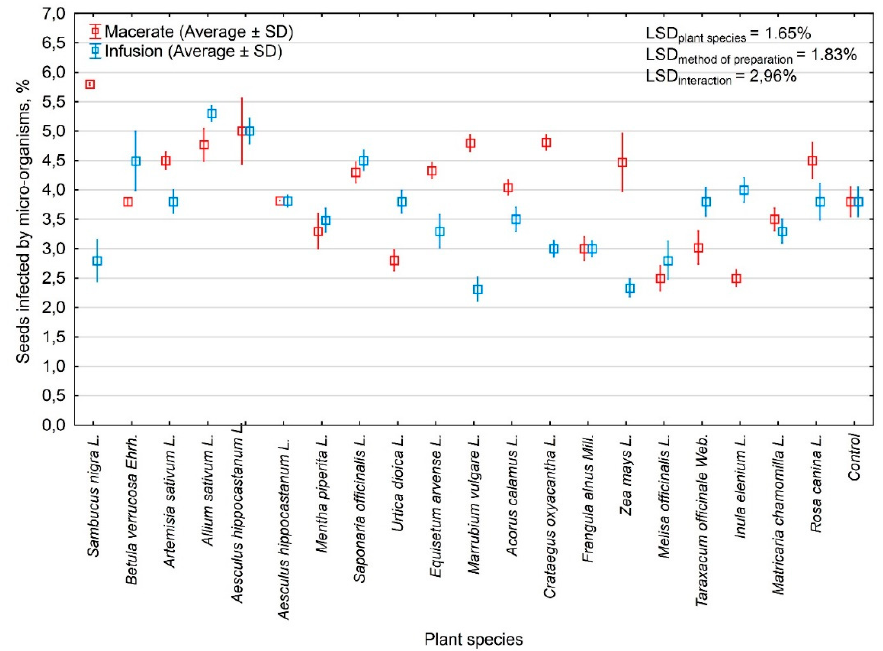
Figure 3. Seeds infected by microorganisms (%) depending on the species of plant from which the the extracts were obtained and the method of extracts were obtained and the method of extraction. SD: standard deviation, LSD: less significant difference.